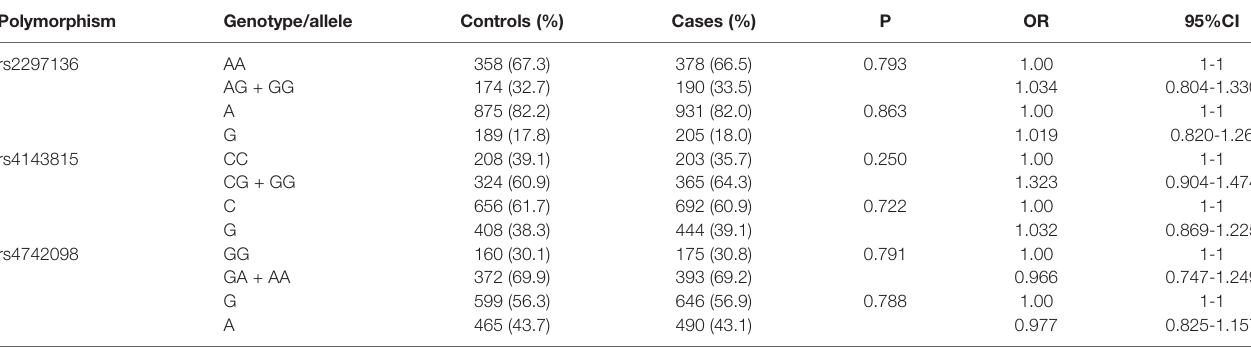
TABLE 3 | Association between the three polymorphisms and the risk of EOC patients.